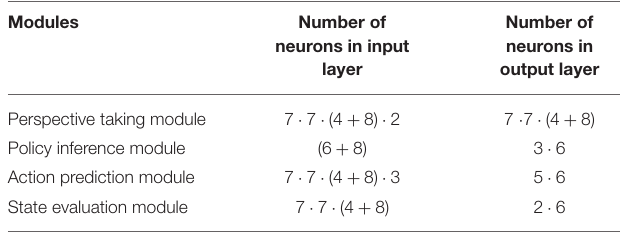
TABLE 2 | The number of neurons in different